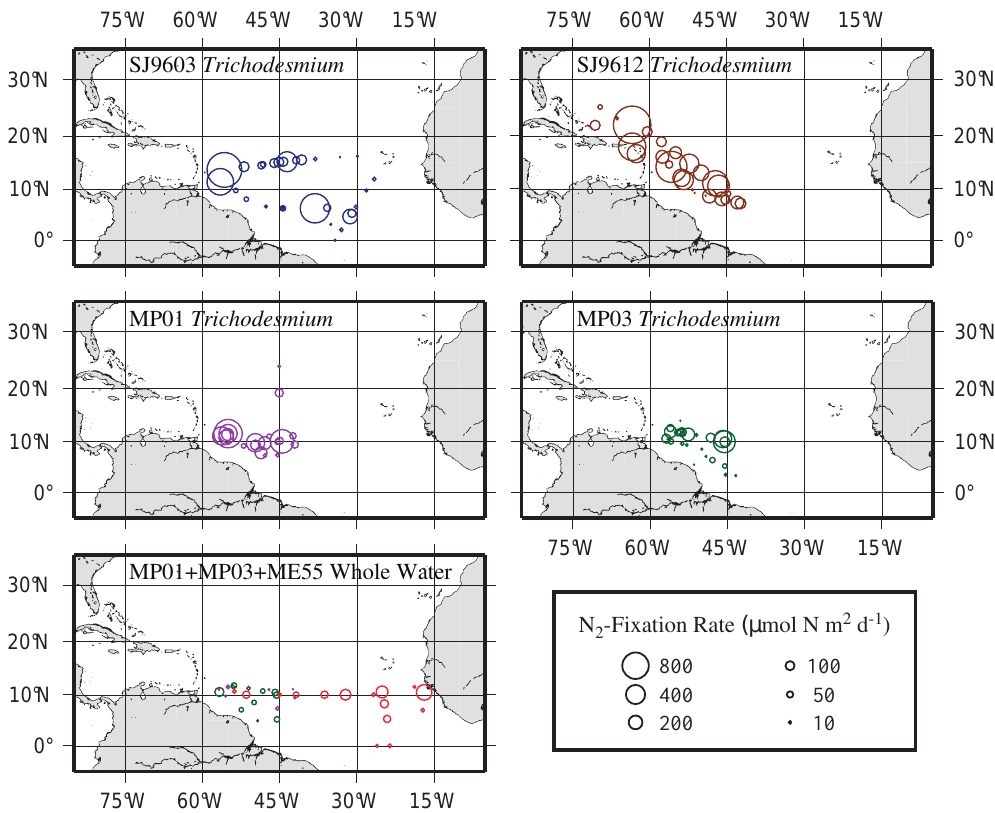
Fig. 3. Areal N 2 fixation rate measurements for Trichodesmium (ARA: cruises SJ9603, SJ9612, MP01, and MP02), and whole water incubations ( 15 N 2 : cruises MP01, MP03, and ME55). Area of each circle is proportional to the integrated rate of N 2 fixation at that station. Colors as in Fig. 1. Charts prepared with GMT (Wessel and Smith,